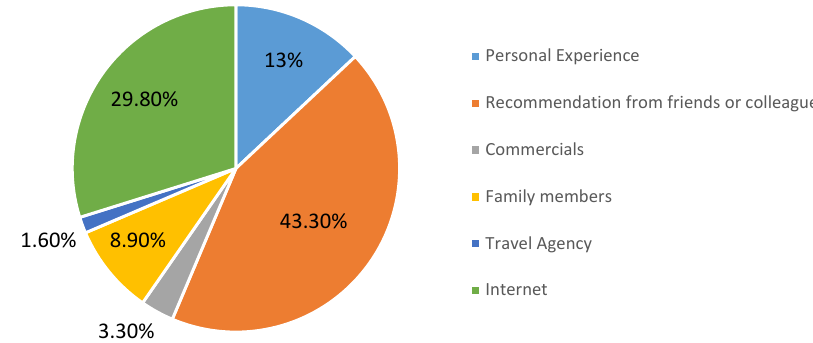
Figure 3. Information source about tourism in Bangladesh